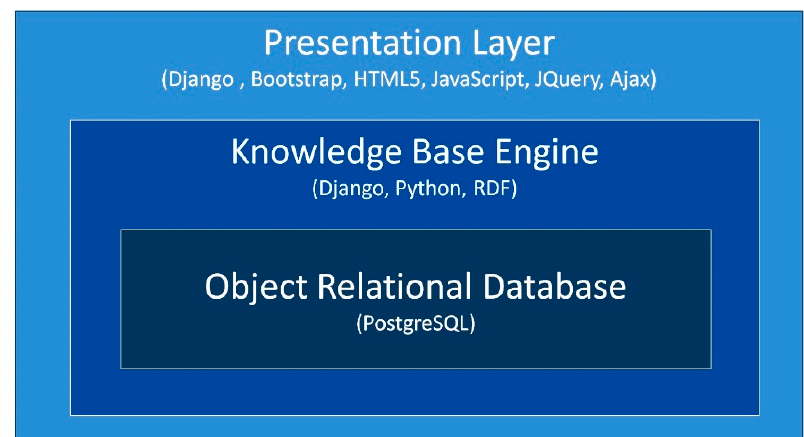
Figure 1. Basic architectural design of the Knowledge Base and main technologies used.